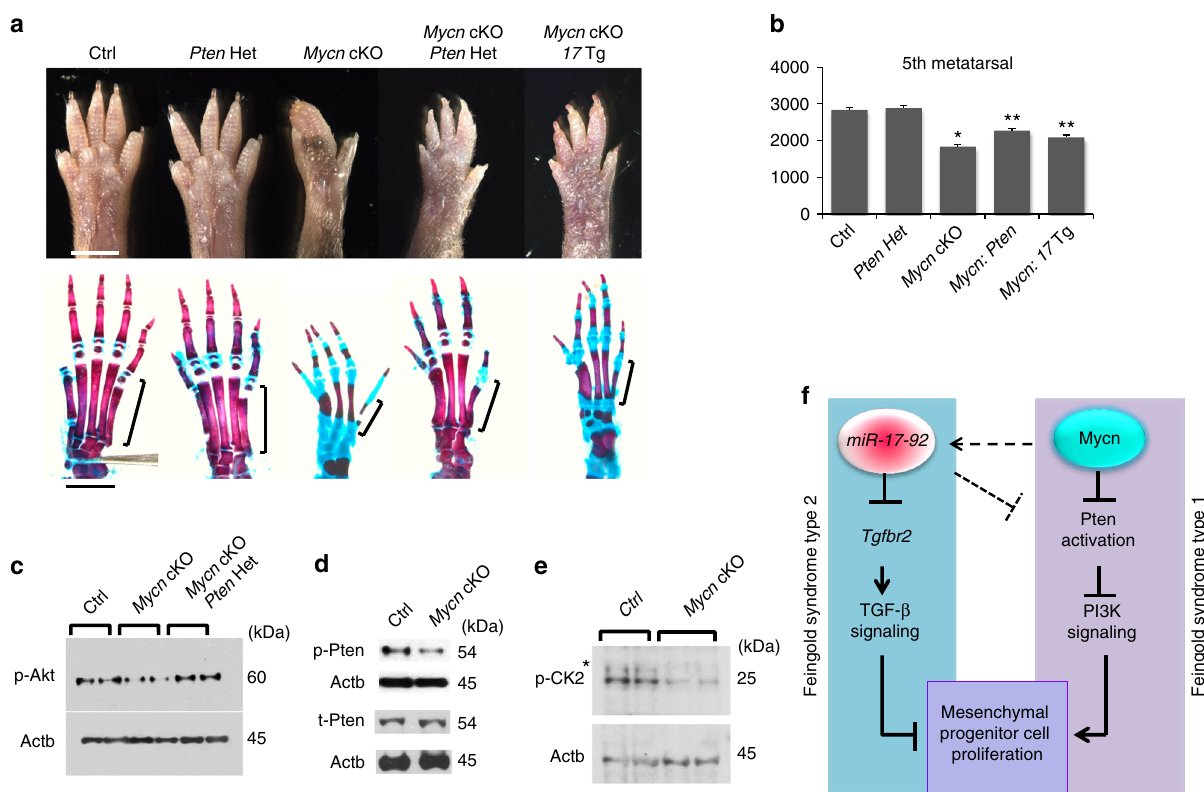
Fig. 6 PI3K downregulation contributes to the Mycn cKO phenotype. a Hindlimbs of mice with indicated genotypes at postnatal day 16. Wildtype control (Ctrl), heterozygous Pten mutant ( Prx1-Cre:Pten fl / + , Pten Het), Mycn Knockout ( Prx1-Cre:Mycn fl / fl , Mycn cKO), Mycn cKO in which one allele of Pten is deleted ( Prx1-Cre:Mycn fl / fl :Pten fl / + , Mycn cKO :Pten Het), and Mycn Knockout overexpressing Mir17-92 ( Prx1-Cre:Mycn fl / fl :Mir17-92 Tg , Mycn cKO :17 Tg). Pten heterozygous deletion partially rescues the skeletal abnormalities of Mycn cKO mutants. Cutaneous syndactyly and brachydactyly are partially rescued, while the fused metatarsals and shortening of mid phalanxes remain. The fi fth metacarpal bones, subjected to measurement in b , are indicated by brackets. Scale bars, 0.5 cm. b Quanti fi cation of the length ( µ m) of fi fth metacarpal bones of mice with indicated genotypes ( n = 6 for Ctrl and Mycn cKO, n = 5 for Pten Het and Mycn cKO :Pten Het , n = 4 for Mycn cKO :17 Tg; * p < 0.01 vs. Ctrl, ** p < 0.01 vs. Mycn cKO). c PI3K signaling was assessed by p-Akt (Thr308) in limb bud cells isolated from E 10.5 mice with indicated genotype. d Immunoblot analysis for phospho-Pten (p-Pten) and total Pten (t-Pten) isolated from Mycn cKO and wildtype littermate limb bud cells. The p-Pten level is decreased in Mycn -de fi cient skeletal progenitor cells whereas the t-Pten level is unchanged. e Immunoblot analysis for casein kinase 2 beta phosphorylation on S209 (p-CK2) in limb bud mesenchymal cells isolated from E10.5 Mycn cKO and wildtype littermates. p-CK2 is decreased in Mycn -de fi cient cells; *non-speci fi c band. f Proposed model. Upregulation of TGF- β signaling plays a causal role in the skeletal defect of Feingold syndrome type 2 ( Mir17-92 mutation), whereas downregulation of the PI3K signaling plays a major pathophysiologic role in Feingold syndrome type 1 ( Mycn mutation). Mycn partially regulates miR-17-92 miRNA levels, but the contribution of this regulation in limb development is limited (dotted arrow). Overexpression of miR-17-92 miRNAs can suppress Pten, although miR-17-92 miRNAs have limited regulatory effects on Pten expression at the physiological level (dotted inhibitory ml, respectively. Ly364947 (1 mg/kg/day) and GW788388 (1 mg/kg/day) were injected intraperitoneally (i.p.) into pregnant mothers or nursing mothers until P7.5. Mice older than P7.5 were individually injected. Skeletal preparation and histology . Alizarin red and alcian blue staining was performed using a modi fi ed McLeod ’ s method 34 . For histological analysis, the embryos were dissected, fi xed in 10% formalin, paraf fi n-processed, cut, and subjected to BrdU staining and TUNEL staining using the In situ Cell Death Detection kit (Sigma-Aldrich).